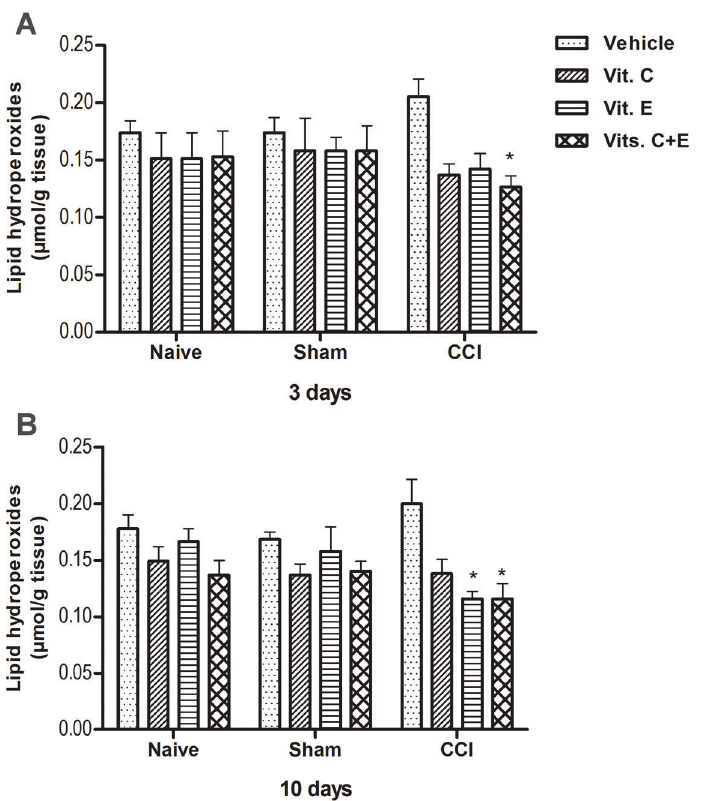
Figure 6. Lipid hydroperoxides levels in the spinal cord of rats treated with vit. C (30 mg (cid:1) kg – 1 (cid:1) day – 1 ), vit. E (15 mg (cid:1) kg – 1 (cid:1) day – 1 ), a combination of these vitamins (vits. C + E) in the same doses, or the vehicle alone (saline containing 1% Tween 80) administered intraperitoneally for 3 ( A ) and 10 ( B ) days after chronic constriction injury (CCI). Data are reported as means ± SE (n=6/group). *P o 0.05 compared to vehicle-treated CCI rats over the same experimental period (two-way ANOVA followed by Tukey post hoc